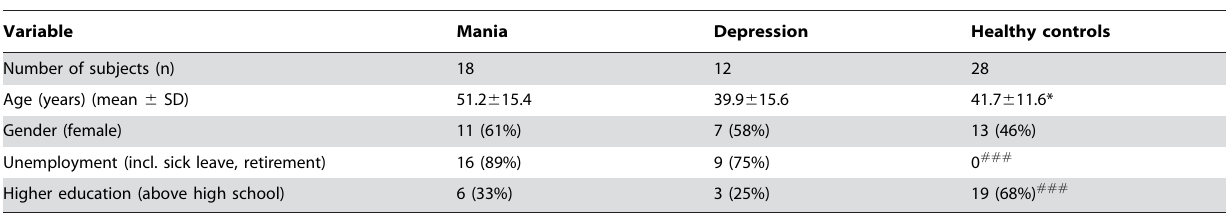
Table 1. Demographic data, all groups.